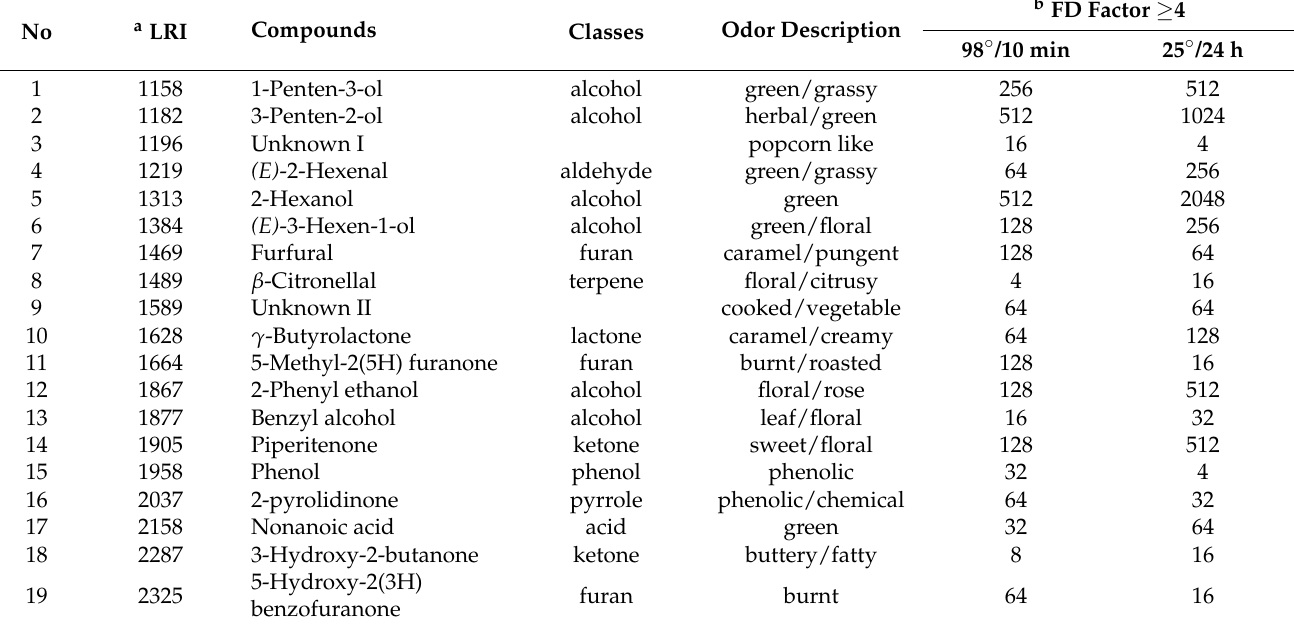
Table 4. Aroma-active compounds of Kinkeliba herbal tea obtained from two infusion